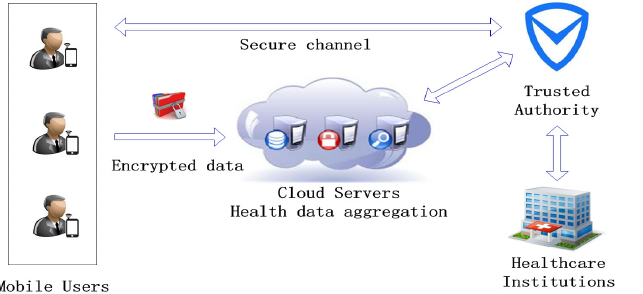
Figure 1. System model of privacy-enhanced and multifunctional health data aggregation scheme